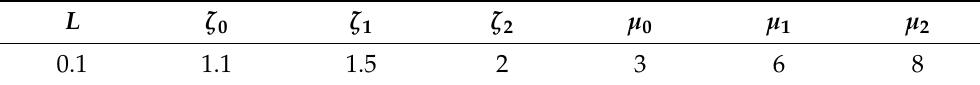
Table 3. Parameters of the non-homogeneous disturbance